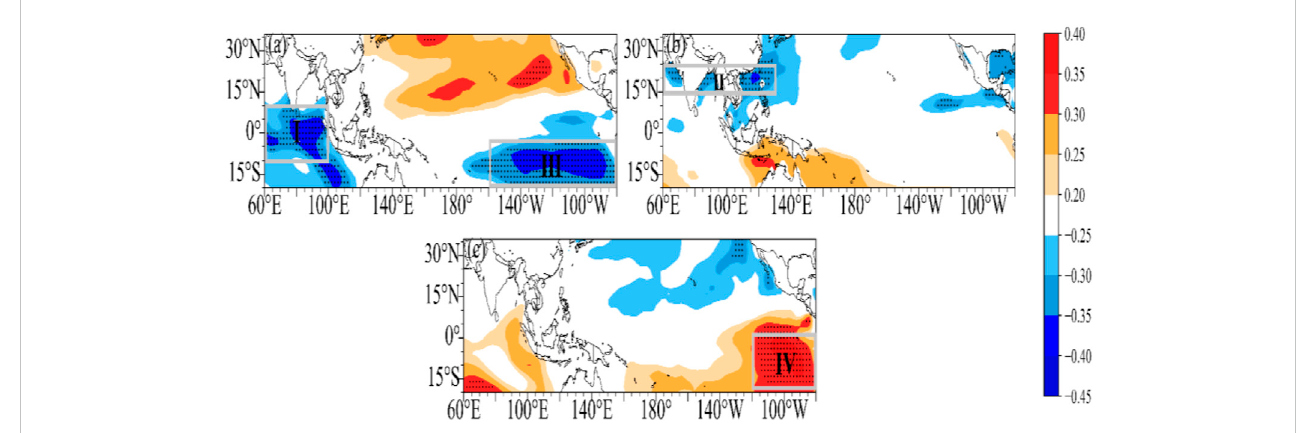
FIGURE 8 The distribution of correlation coef fi cients between the sea surface temperature in the early autumn (A) , winter (B) , and spring (C) , and the Meiyu onset date from 1954 to 2020 (the dotted area passed the 99%